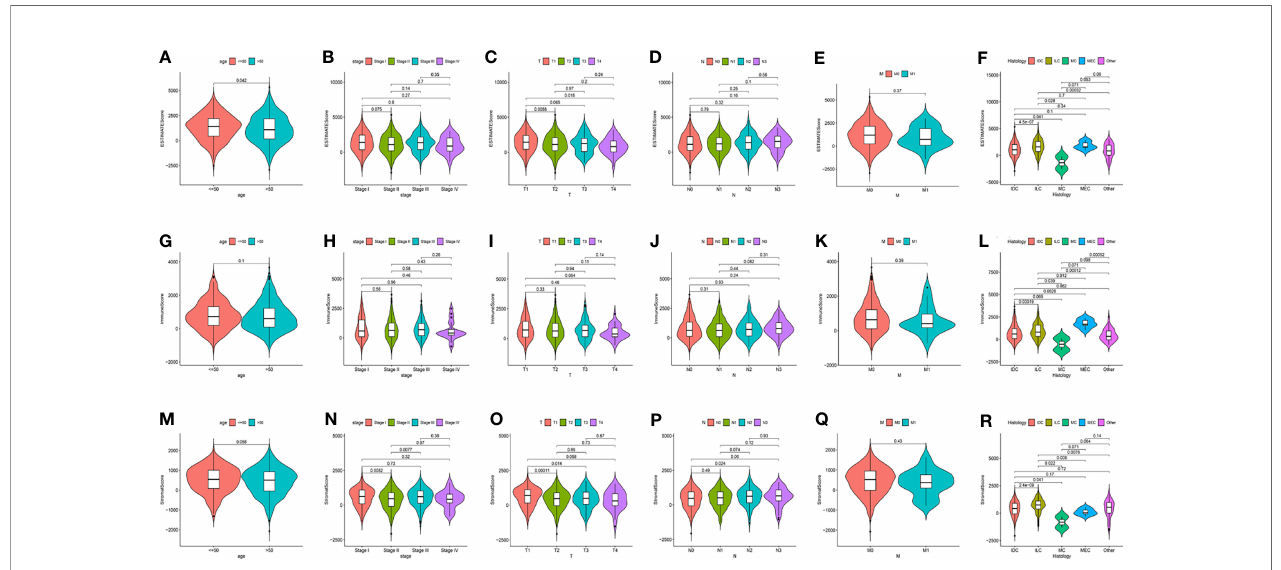
FIGURE 2 | The relations between the Scores and Clinical Characteristics in patients with BC. (A – F) ESTIMATE Score in age, TNM staging, and histology. (G – L) Immune Score in age, TNM staging, and histology. (M – R) Stromal Score in age, TNM staging, and histology. IDC, In fi ltrating Ductal Carcinoma; ILC, In fi ltrating Lobular Carcinoma; MC, Mucinous Carcinoma; MEC, Medullary